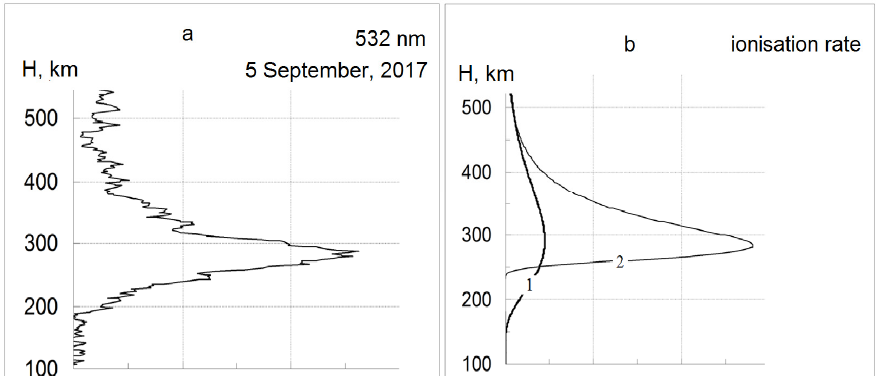
Figure 9. Vertical profiles of the lidar signal ( a ) and ionization rate for the Maxwell (curve 1) and mono-energy (curve 2) spectra of precipitated electrons ( b ).